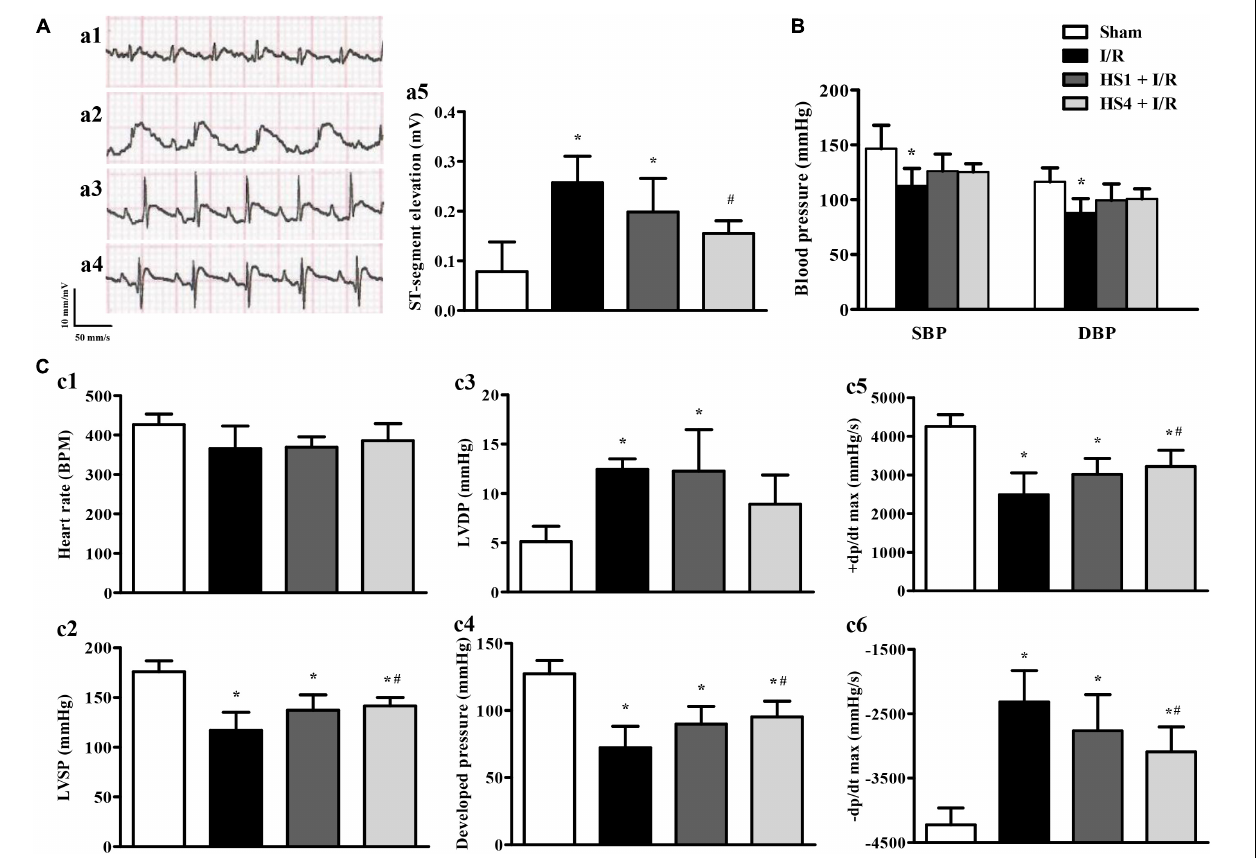
FIGURE 3 | Effect of Herba Siegesbeckiae (HS) on ST-segment, blood pressure, and cardiac function induced by Ischemia/Reperfusion (I/R). (A) Representative ECG of thoracic lead II in Sham (a1), I/R (a2), HS1 + I/R (a3), and HS4 + I/R (a4) groups, and quantitative analysis of ST-segment elevation among the four groups at 120 min after reperfusion (a5). (B) Quantitative analysis of systolic blood pressure (SBP) and diastolic blood pressure (DBP) in Sham ( n = 6), I/R ( n = 7), HS1 + I/R ( n = 7), and HS4 + I/R ( n = 6) groups. (C) Quantitative analysis of heart rate (HR, c1), left ventricular systolic pressure (LVSP, c2), left ventricular diastolic pressure (LVDP, c3), left ventricular developed pressure (c4), left ventricular maximum upstroke velocity (+ dp/dt max, c5), and left ventricular maximum descent velocity (-dp/dt max, c6) in Sham ( n = 6), I/R ( n = 7), HS1 + I/R ( n = 7), and HS4 + I/R ( n = 6) groups. ∗ P < 0.05 vs. Sham group, # P < 0.05 vs. I/R